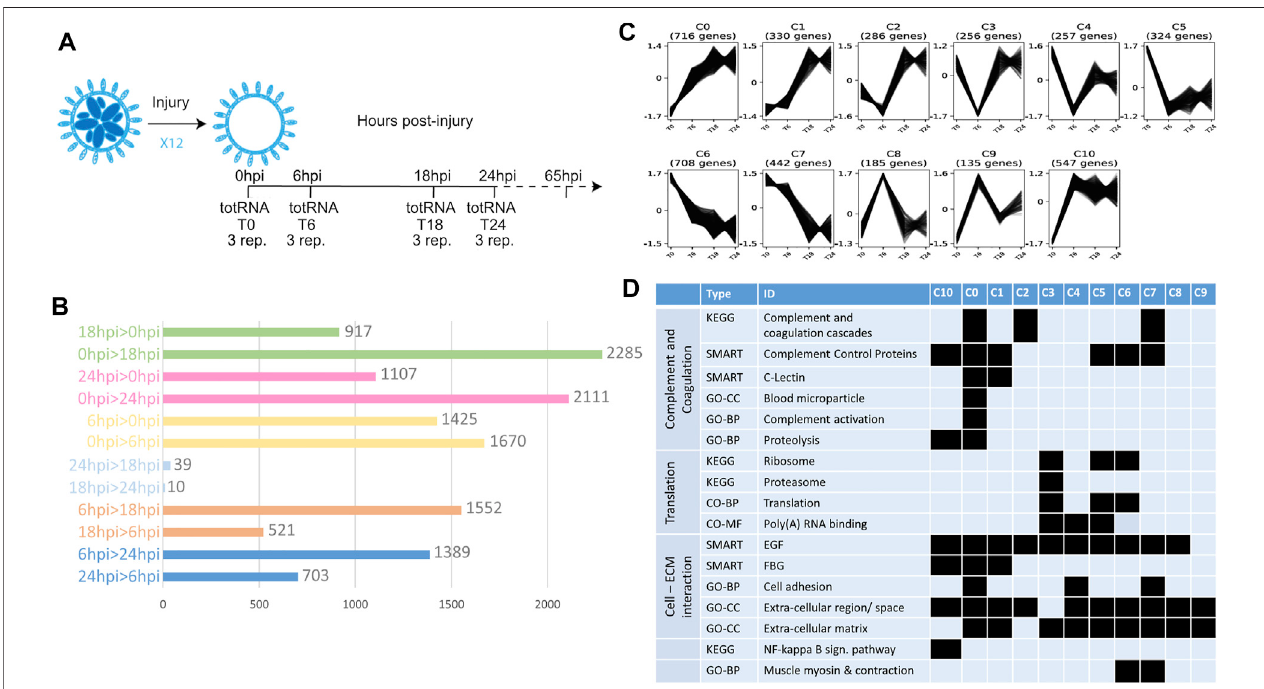
FIGURE 1 | Transcriptomic pro fi le of early steps of WBR in B. schlosseri . (A) Scheme showing the experiment design for transcriptome characterization of early WBRstepsin B.schlosseri .Inadditiontotheharvestedcolonies,additionalcloneswereallowedtoregeneratefor65 hpitocertifytheWBRabilityoftheclone. (B) Graph showing the number of contigs differentially expressed between each condition. (C) The eleven clusters of expression pro fi le and the number of contigs in each cluster (D) Chosen examples of functional categories statistically enriched across the eleven clusters, extracted from Supplementary Table S1 . GO-CC, Gene Ontology — Cell Compartment; GO-BP, Gene Ontology — Biological Process; GO-MF, Gene Ontology — Molecular Function.